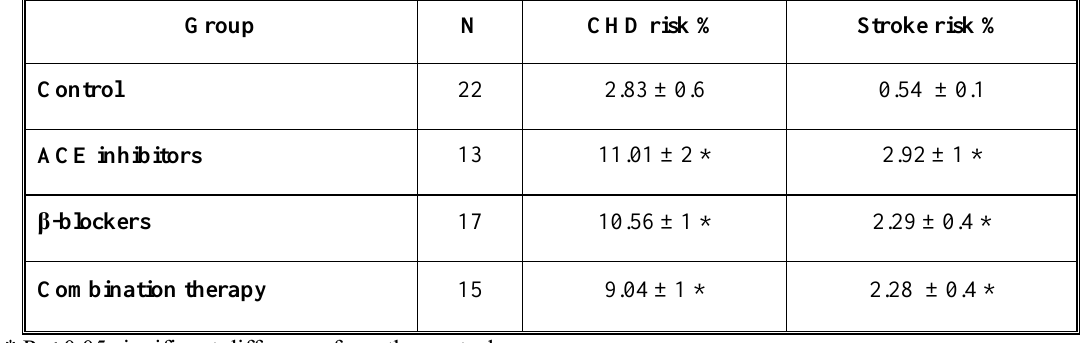
Table 13: CHD risk % and stroke % based on DBP in control healthy individuals and non-diabetic hypertensive patients treated with different antihypertensive drug regimens. Each value represents mean± standard error of mean.